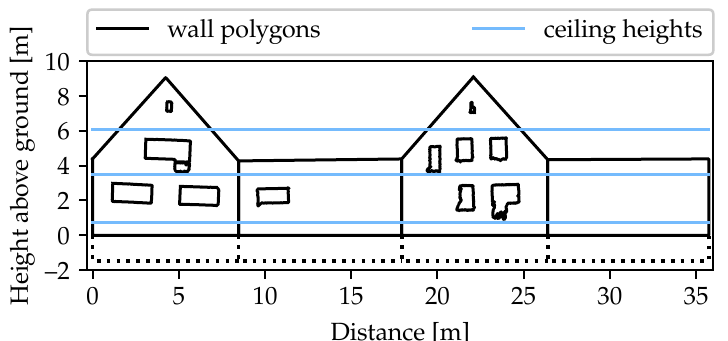
Figure 3. Projected wall polygons with ceiling heights automatically detected from window positions. Dotted lines mark wall polygons below